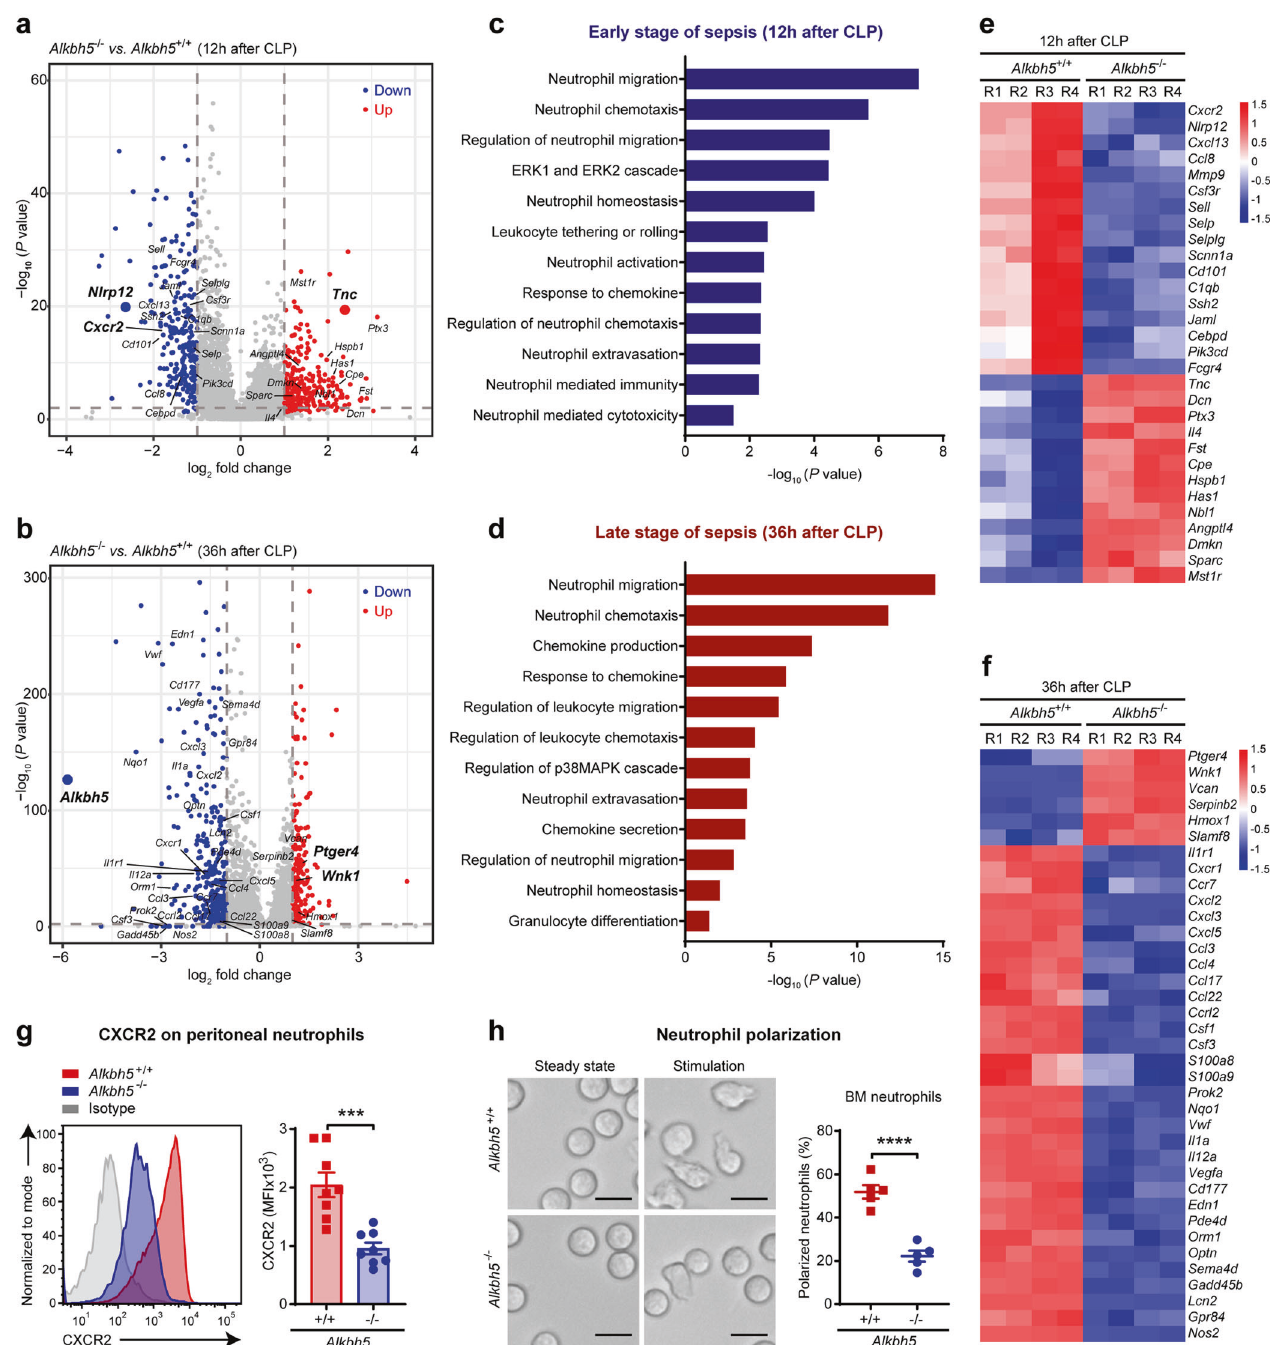
Fig. 4 ALKBH5 imprints migration-promoting transcriptome signatures in neutrophils in antibacterial defense. a , b Volcano plots of gene expression pro fi les in peritoneal neutrophils from Alkbh5 -de fi cient mice ( Alkbh5 – / – ) and WT littermates ( Alkbh5 + / + ) at 12 h ( a ) or 36 h ( b ) after mild CLP, respectively. a was zoomed-in partial region of complete volcano plot (For complete volcano plot of CLP 12 h, see Supplementary Fig. S6c). Genes with signi fi cant changes in expression upon Alkbh5 de fi ciency were colored by red for up-regulated genes and by blue for down-regulated genes. Alkbh5 and its potential targets were labeled near bigger plots. Four independent biological replicates. c , d Visualization of the GO biological processes enrichment analysis of the signi fi cantly differentially expressed genes (DEGs) upon Alkbh5 de fi ciency with annotations of neutrophil association. The early stage of sepsis showed signi fi cantly DEGs at 12 h after mild CLP ( c ); the late stage of sepsis showed signi fi cantly DEGs at 36 h after mild CLP ( d ). e , f Heatmap showing the expression variations of the DEGs (related to neutrophil migration and chemotaxis) in peritoneal neutrophils from Alkbh5 -de fi cient mice ( Alkbh5 – / – ) versus WT littermates ( Alkbh5 + / + ) at 12 h ( e ) or 36 h ( f ) after mild CLP, respectively. Four biological replicates (R1 to R4). g FACS analysis of protein expression of CXCR2 on cell- surface of peritoneal neutrophils from Alkbh5 -de fi cient mice and WT littermates at 12 h after mild CLP ( n = 8). h Polarization assay of bone marrow neutrophils from normal Alkbh5 -de fi cient mice and WT littermates. Scale bars, 10 μ m. The percentage of polarized neutrophils (cells that ruf fl ed or extended pseudopods) was calculated after E.coli and CXCL2 stimulation ( n = 5). All data are mean ± SEM of biologically independent samples. Data are representative of 5 or 8 independent experiments with similar results ( g, h ). *** P < 0.001; **** P < 0.0001. Two- tailed unpaired Student ’ s t test ( g, h ) Signal Transduction and Targeted Therapy (2022)